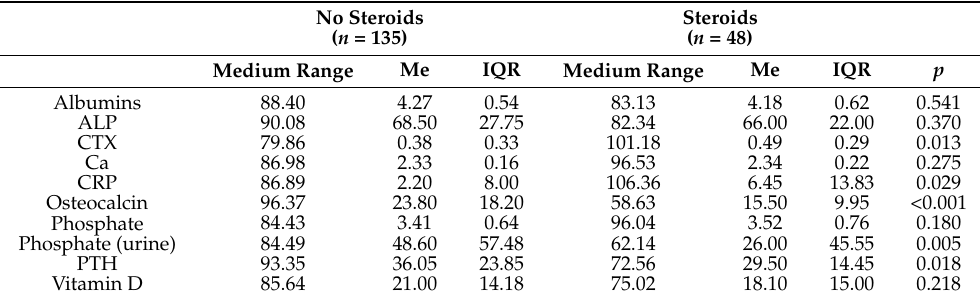
Table 5. Biochemical markers of bone metabolism in patients receiving and not receiving